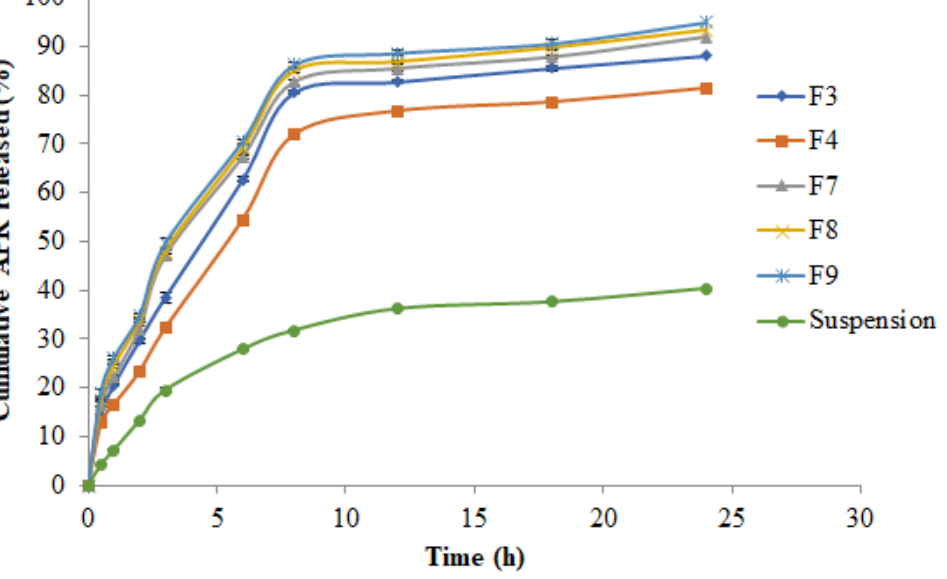
Figure 3. Cumulative in vitro release of APR from prepared APR-SNEDDS and APR suspension via dialysis membrane over 24 h. Table 5. The correlation coefficients and kinetics of APR release from SNEDDS and suspension.